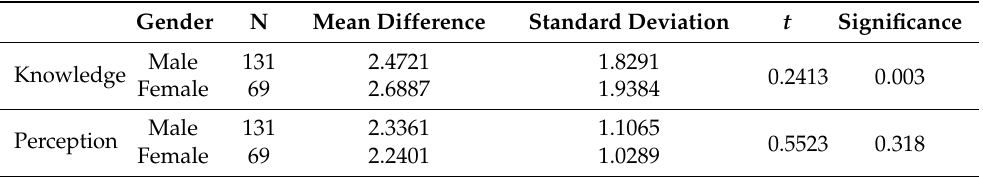
Table 6. Knowledge and perception t -test results on willingness to participate in e-waste management. Gender N Mean Difference Standard Deviation t